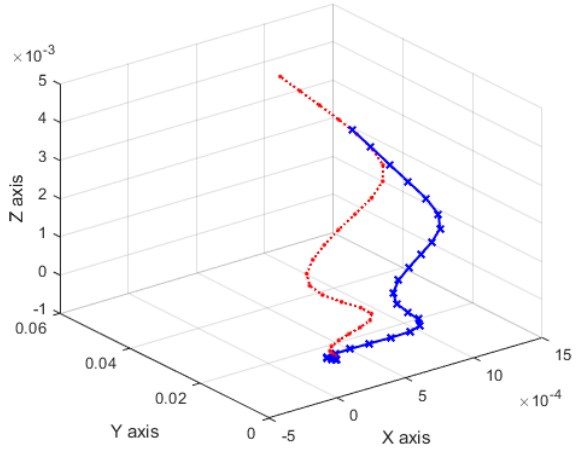
Figure 10. 3D trajectories diagram of VWM and fVWM warped by DTW for GLR model optimization (GLR-DTW).